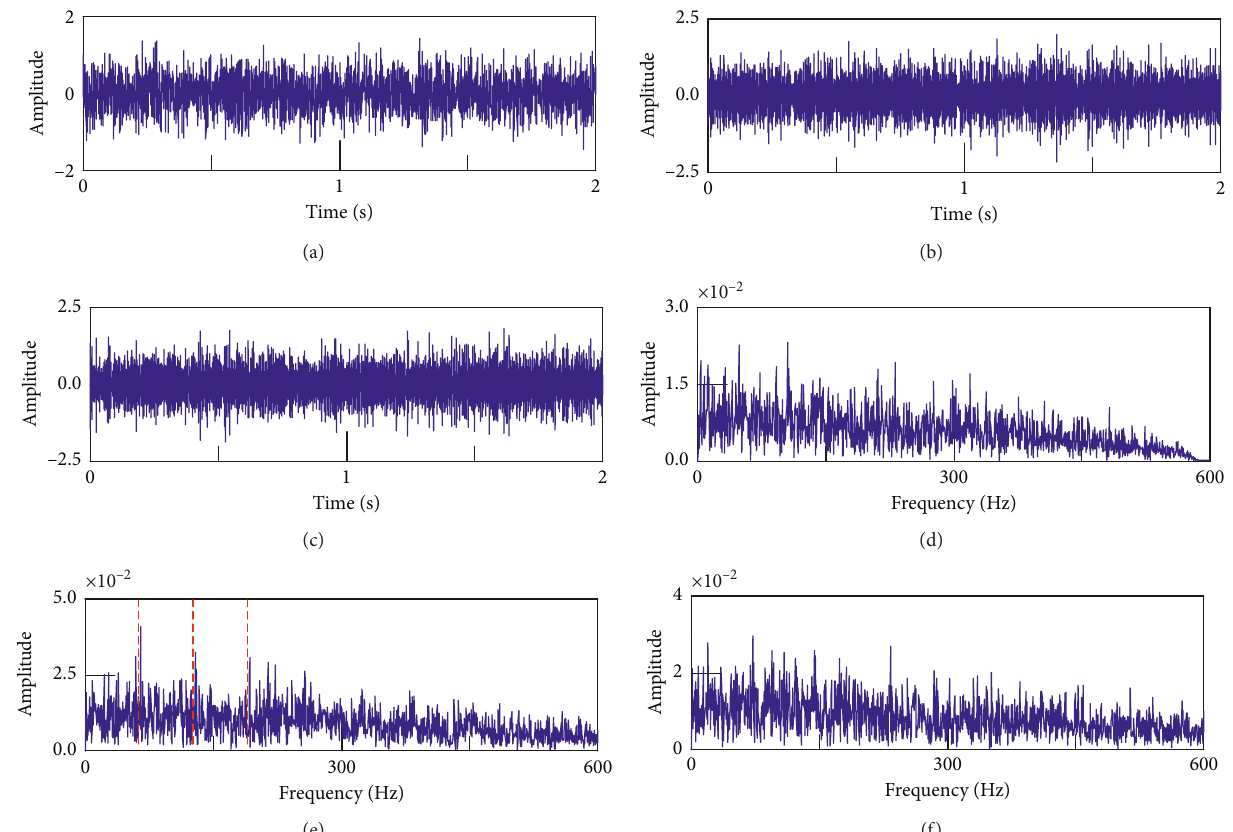
Figure 11: The proposed EWTOSSR method for diagnosing a simulated signal: (a–c) sub-band signals; (d–f) squared envelope spectra (red dashed lines: the first three harmonics of the characteristic fault frequency 1/ T p